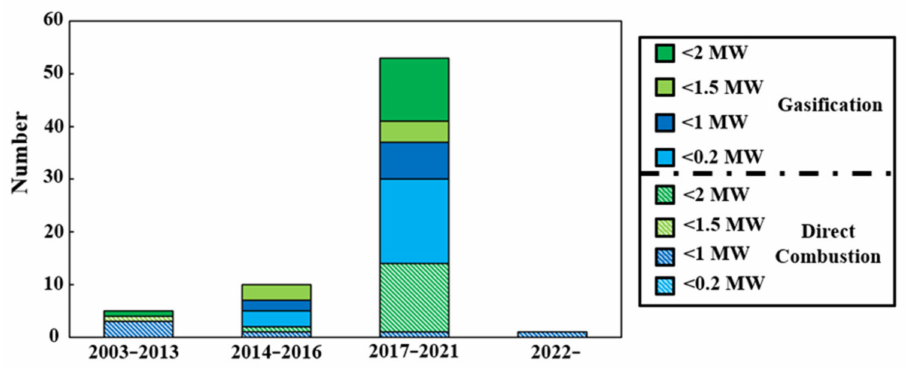
Figure 3. Details of woody biomass power generation projects of less than 2